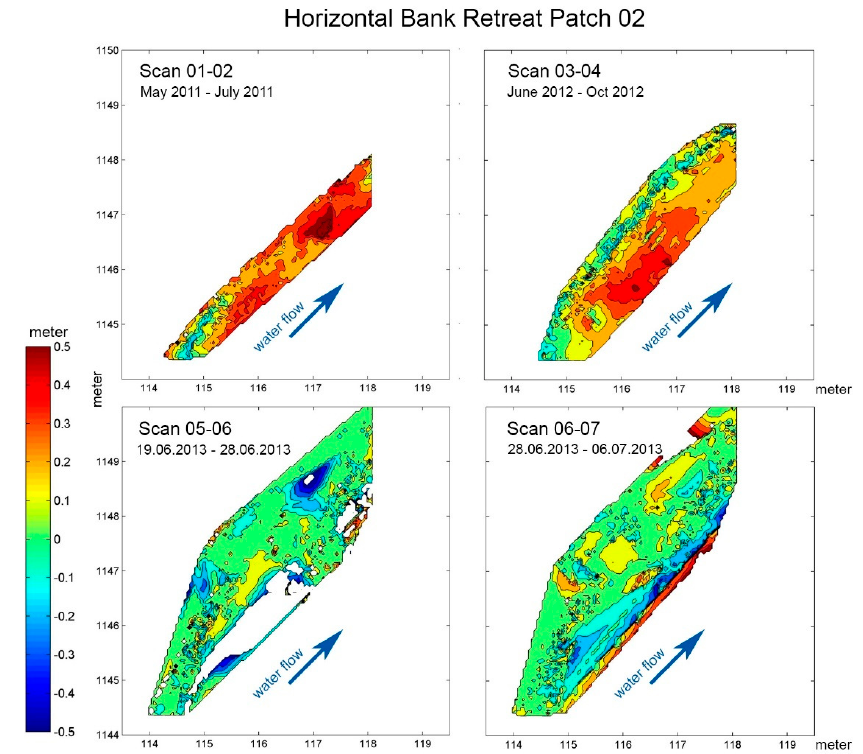
Figure 3. Horizontal bank retreat for patch 02 between scans. Table 3. Change of riverbank. MVSG, mean vertical slope gradient, and significance of change with